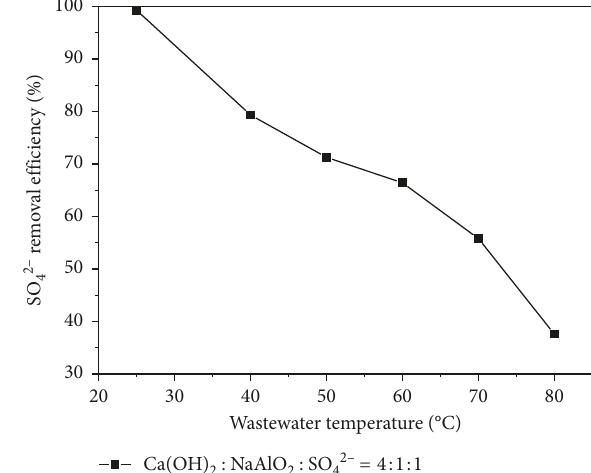
Figure 4: The effect of solution temperature. V v